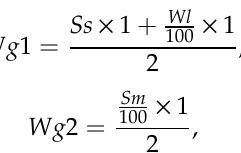
Figure 3. ( a ) Topographical elevation (m) and ( b ) elevation relative to the water level.